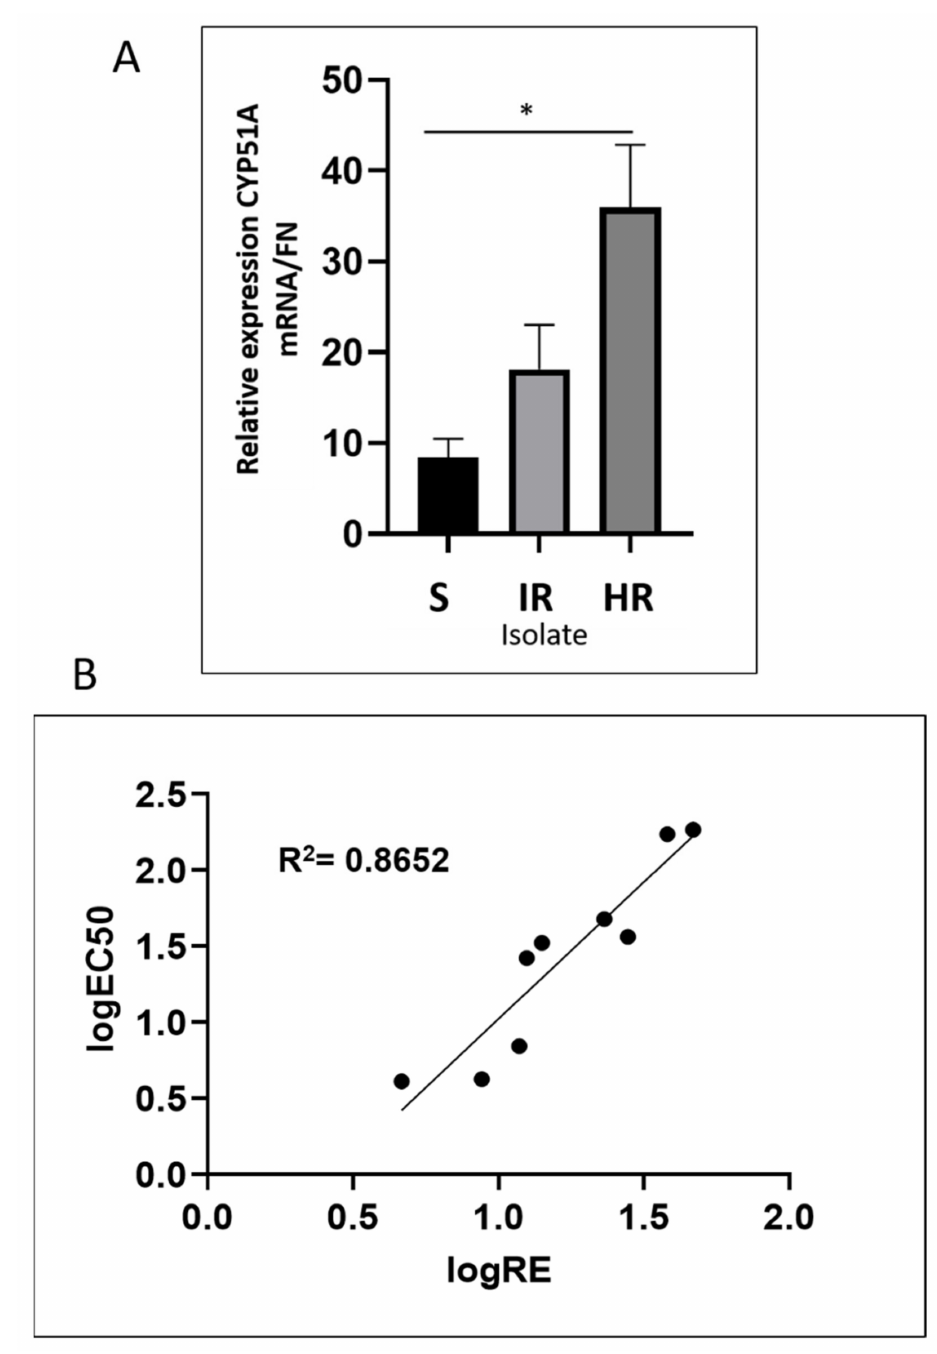
Figure 5. Relative expression of CYP51 and correlation with isolates’ sensitivity. ( A ) Graphical representation of the relative expression (RE) calculated with the reference FON gene using the 2 − ∆∆ Ct method. Asterix (*) indicates significant differences between sensitive and resistant groups. ( B ) Correlation between RE and EC 50 values of Fusarium oxysporum f. sp. niveum (FON). R 2 value = 0.8652, showing a positive and statistically significant correlation between gene expression and growth on